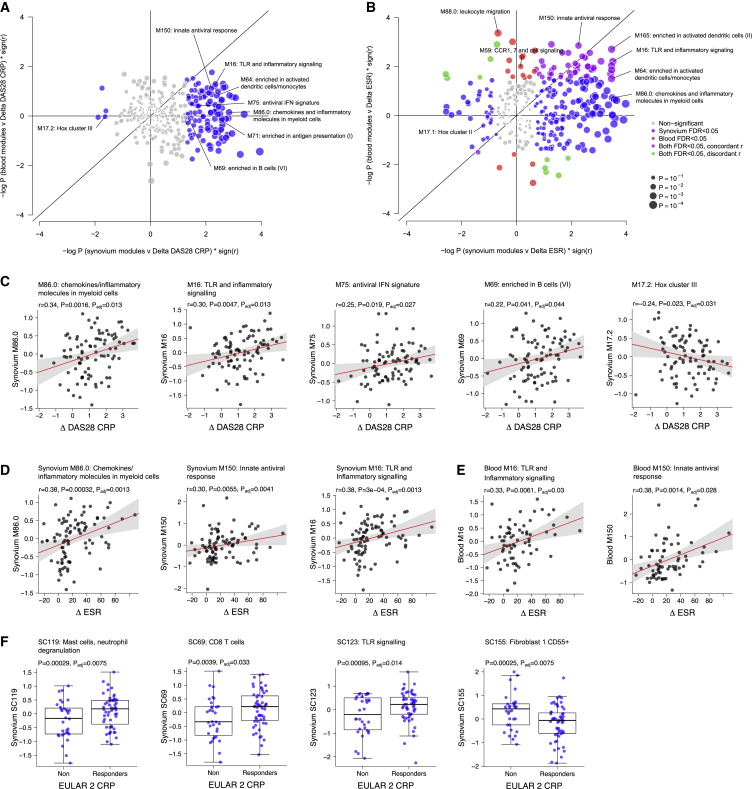
Association of RNA-Seq Modules and Response to 6 Months of DMARD Treatment(A and B) Correlation of gene modules in synovium (x axis) versus blood (y axis) with 6-month response to DMARD treatment measured by (A) delta DAS28-CRP and (B) delta ESR. Significantly correlated synovial modules (at FDR < 0.05) are shown in blue, significant blood modules in red, and modules, which concordantly correlate with each clinical parameter in both synovium and blood, are shown in purple.(C) Correlation of synovium gene modules with delta DAS28-CRP from baseline to 6 months.(D and E) Correlation of (D) synovium and (E) blood gene modules against change in ESR from baseline to 6 months following DMARD treatment. Statistical analysis by Spearman correlation with FDR adjustment (A–E).(F) Differential expression of synovial single-cell-annotated WGCNA modules between EULAR DAS28-CRP responders (good and moderate) and non-responders. Statistical analysis by QuSAGE with FDR adjustment.